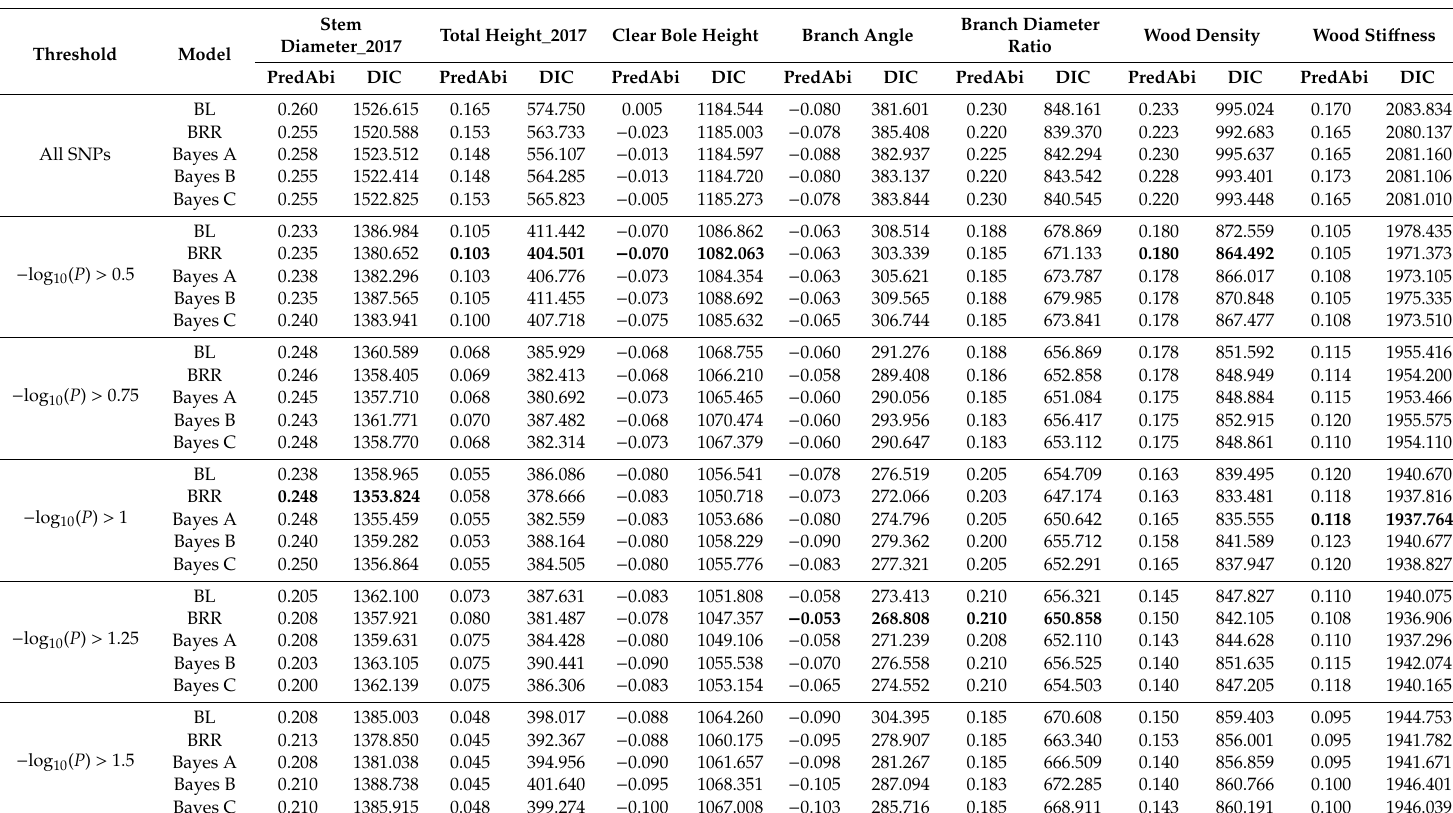
Table 3. Mean predictive ability and Deviance Information Criterion of growth, branch and wood quality traits of the S. platyclados population, after thinning, derived using all SNPs and sets meeting GWAS-based criteria obtained with indicated Bayesian models (Bayesian LASSO, Bayesian Ridge Regression, Bayes A, Bayes B and Bayes